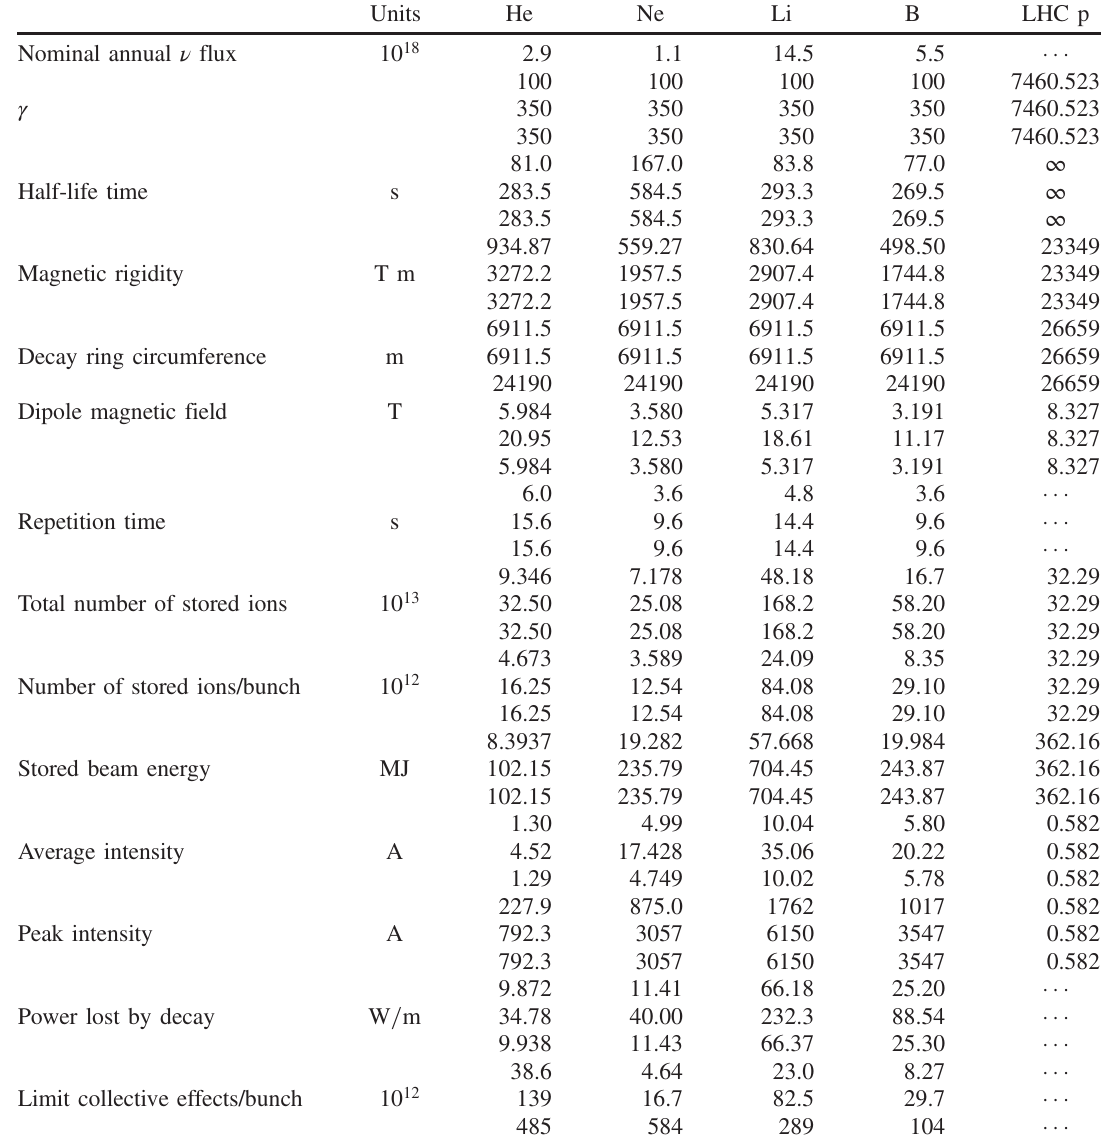
TABLE XII. Decay ring at γ ¼ 100 , γ ¼ 350 high and low dipole field and LHC for